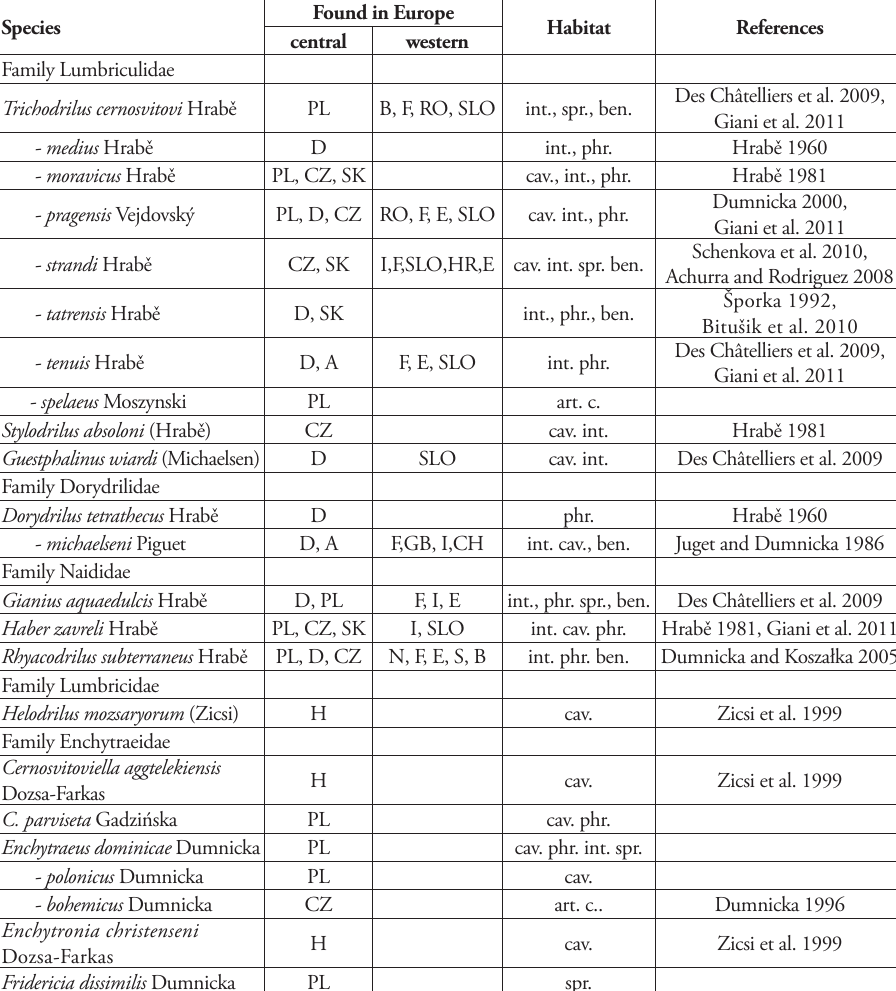
Table 2. Distribution of stygobitic oligochaetes known from Central Europe. References concerning species distribution in Poland are in Table